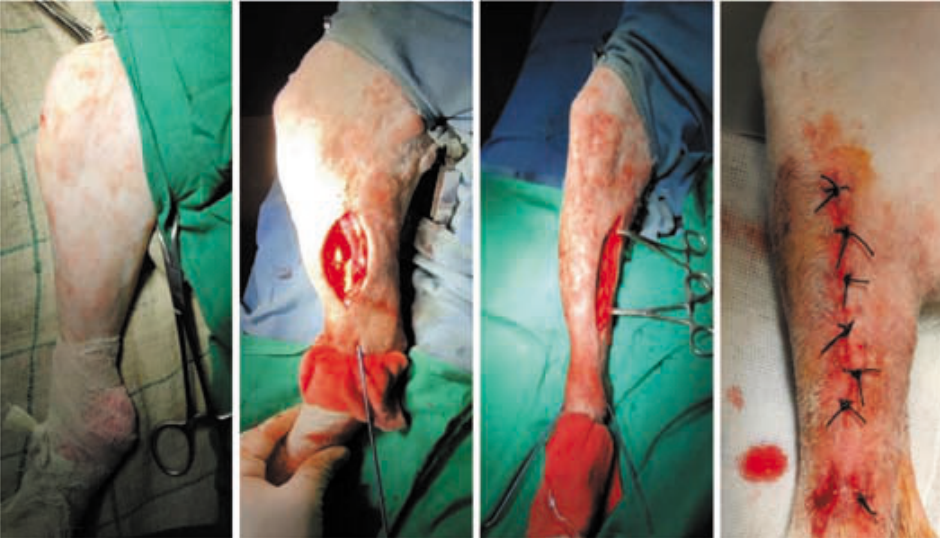
Fig. 2. Intraoperative photographs showing titanium elastic stable intramedullary nailing in dog with fracture of tibia at mid